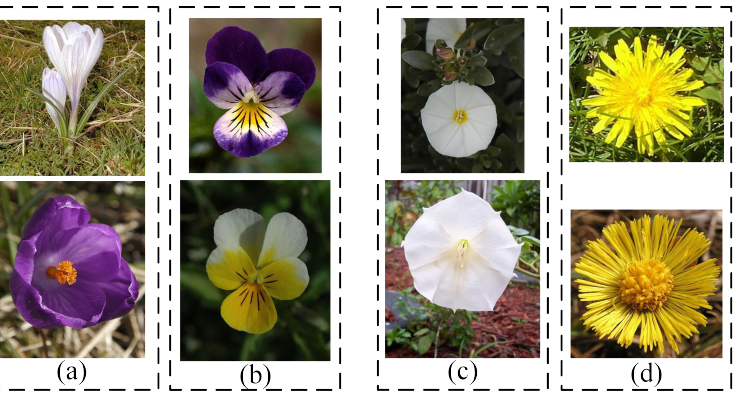
Figure 1. ( a ) Intra-class differences of crocus. ( b ) Intra-class differences of pansy. ( c ) Inter-class similarities between silverbush and thorn apple (the above is silverbush, the below is a thorn apple). ( d ) Inter-class similarities between dandelion and coltsfoot (the above is dandelion, the below is a